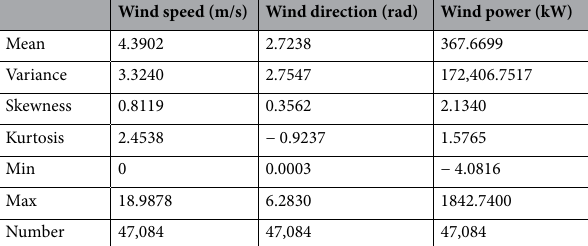
Table 1. Statistical description of wind speed, its direction and wind power data. The data records corresponding to the periods of averaged 10 min each and containing wind speed, wind direction and wind power data for 1.8 MW wind turbine collected from supervisory control and data acquisition (SCADA) systems.